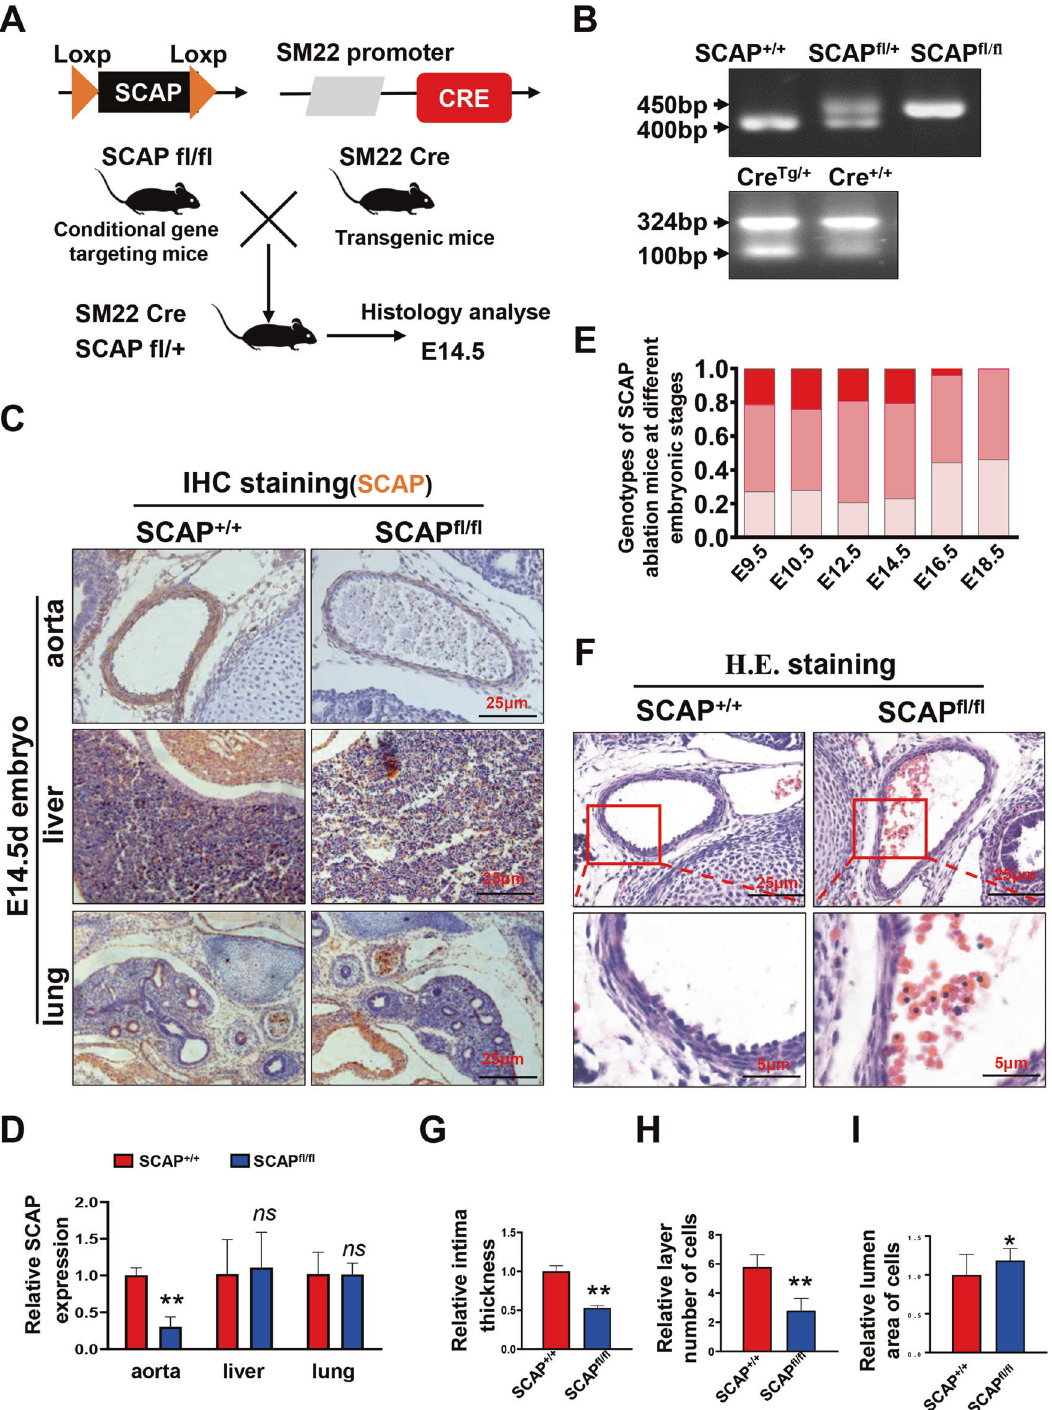
Fig. 1 Ablation of SCAP in VSMCs leads to vessel wall thinness in mouse embryos. A Brief overview of the animal model generation procedure. VSMC-speci fi c SCAP ablation mice were generated by crossing conditional gene targeting mice with conditional loxP- fl anked SCAP (SCAP fl ox/ fl ox ) alleles and SM22-Cre mice. Embryos and placentas were collected on E14.5d. B PCR results of genotyping of mouse tails or embryonic tissue samples con fi rmed the generation of SM22 α -Cre + SCAP fl ox/ + mice, SM22 α -Cre + SCAP fl ox/ fl ox mice (SCAP fl / fl ) and SM22 α -Cre + SCAP + / + (SCAP + / + ). C Immunohistochemistry analysis of SCAP in embryonic aorta, liver, and lung ( n = 6). Scale bar = 25 μ m. D Statistical analysis of relative SCAP expression measured in ( C ) ( n = 6). E Statistical analysis of the genotypes of SCAP ablation mice at different embryonic stages ( n = 132). F H&E staining of embryonic aorta sections at E14.5 ( n = 6). Scale bar = 25 μ m. Enlarged views of the red boxes are shown. Scale bar = 5 μ m. G Statistical analysis of the relative intima thickness in SCAP + / + and SCAP fl / fl mice at E14.5d ( n = 6). H Statistical analysis of relative layer number of cells in SCAP + / + and SCAP fl / fl mice at E14.5d ( n = 6). I Statistical analysis of relative lumen area of cells in SCAP + / + and SCAP fl / fl mice at E14.5d ( n = 6). Data are presented as the mean ± SD. * P < 0.05, ** P < 0.01, *** P < 0.001. P values were calculated by Student ’ s t test.